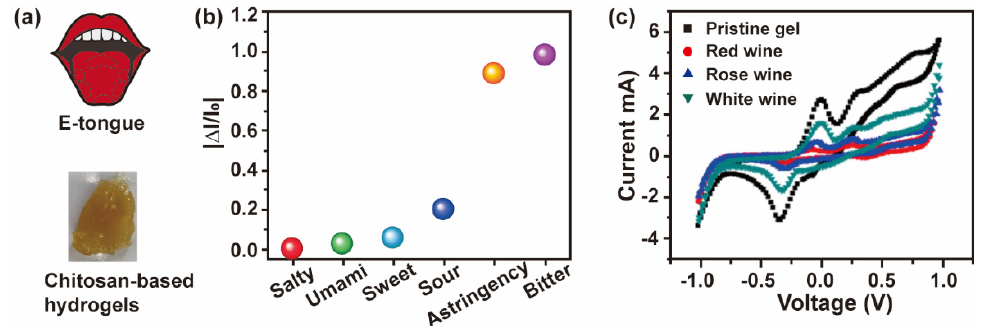
Figure 6. ( a ) Schematic and photograph of a chitosan-based bioelectronic sensor. ( b ) Selective sensing of five tastes and astringency by E-tongue. ( c ) Cyclic voltammetry measurement of real beverage samples. Adapted with permission from ref [6]. Copyright (2022) Elsevier.